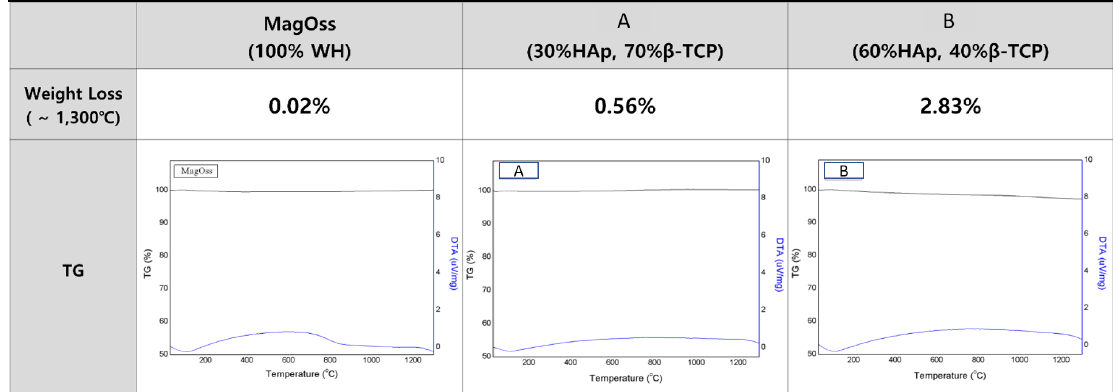
Figure 4. TG/DTA patterns of different bone grafts. The total weight loss of bone graft products as measured by thermogravimetric analysis to 1300 ◦ C was found to be less than 5%. The total weight loss of the MagOss group was 0.02%, that of Group ( A ) was 0.56%, and that of Group ( B ) was 2.83%. It was confirmed that there was no degradation or phase translation to 1300 ◦ C.